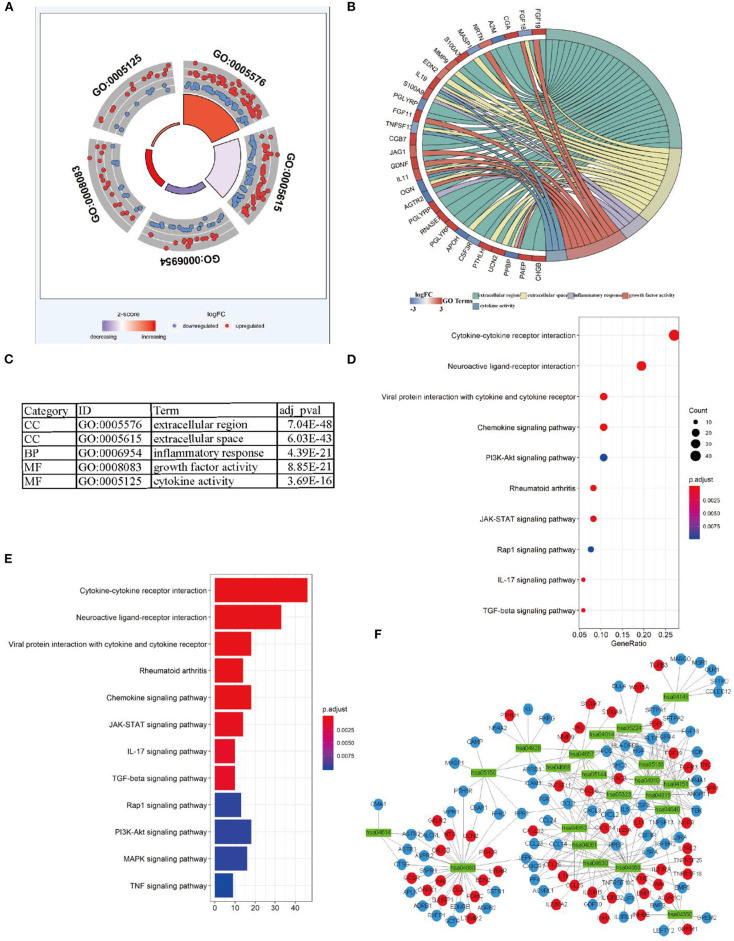
Functional enrichment analysis of differential expression IRGs in LUSC. (A) The outer circle shows the expression (logFC) of differential expression IRGs in each enriched GO terms: red dots which were on each Go terms indicated the up-regulation differential expression IRGs. Blue dots indicated the down-regulation differential expression IRGs. The inner-circle shows the prominence of GO terms (log10-adjusted P-values). (B) The circle represents the relationship between statistically top 30 differential expression IRGs and their GO terms. (C) The top five most significant GO terms and their annotations. (D) The top 10 pathways which were enriched in differential expression IRGs were showed in the dot plot. (E) The top 12 pathways which were enriched in differential expression IRGs were showed in the barplot. (F) the significantly statistically different 21 pathways were used Cytoscape software for constructing a pathway-IRG network with differential expression IRGs. The green rectangles indicate the pathways, the red circles indicate the up-regulation differential expression IRGs, the blue circles indicate the down-regulation differential expression IRGs.